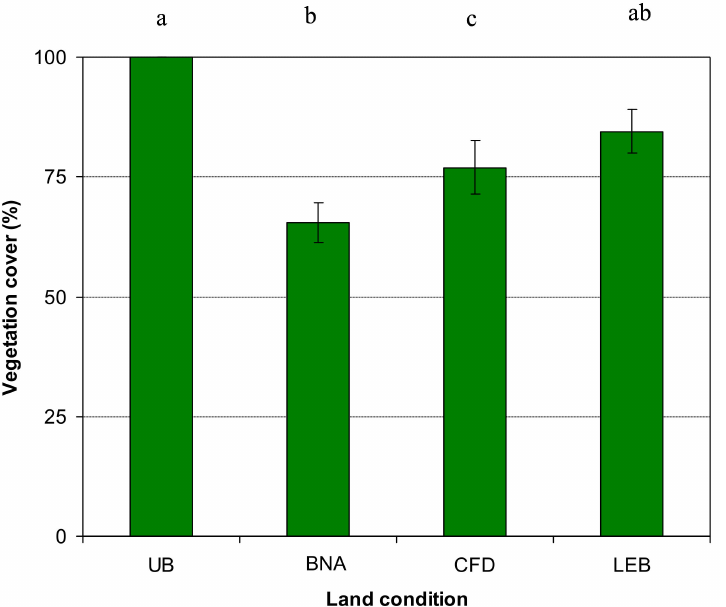
Figure 5. Vegetation cover (mean ± standard deviation of 62 plots) in plots under four land conditions (UB = unburned; BNA = burned and no action; CFD = contour-felled log debris; LEB = log erosion barriers) after the wildfire of 2012 in Sierra de Los Donceles forest (Castilla-La Mancha, Spain). Mean values that do not share a lower case letter (top of graph) are significantly different from each other (HSD, p <